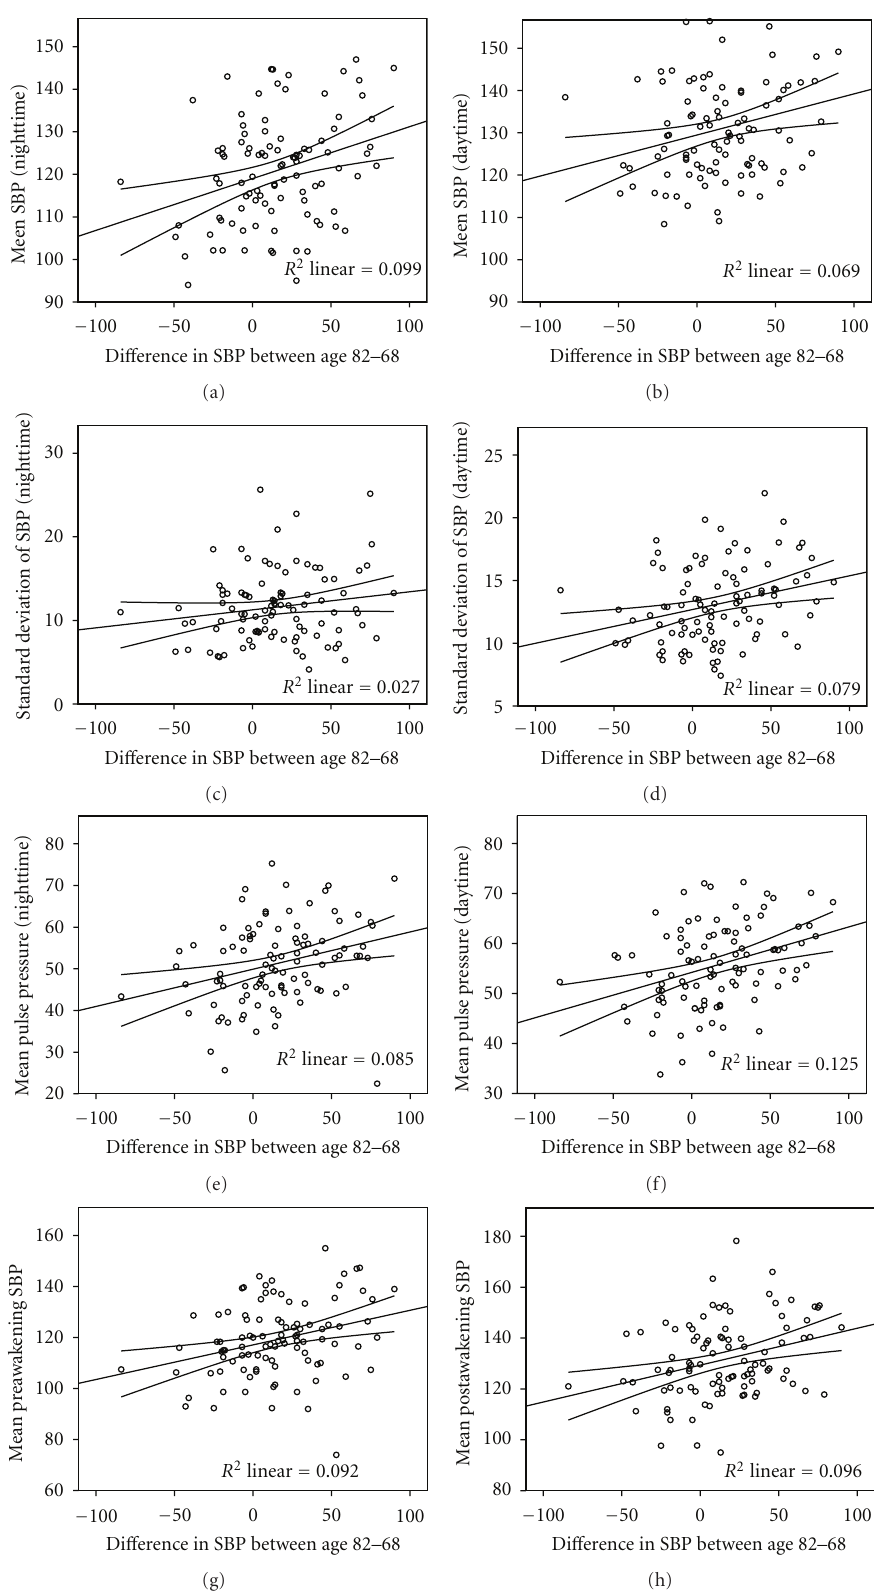
Figure 2: Correlation between an arithmetic di ff erence in SBP, measured at ages 81 and 68 and ambulatory blood pressure measures collected at age 82 (daytime, nighttime, pre- and postawakening SBP, SBP variability, that is, daytime and nighttime standard deviation of SBP measurements and daytime and nighttime pulse pressure). Positive di ff erence in SBP means an increasing SBP during the